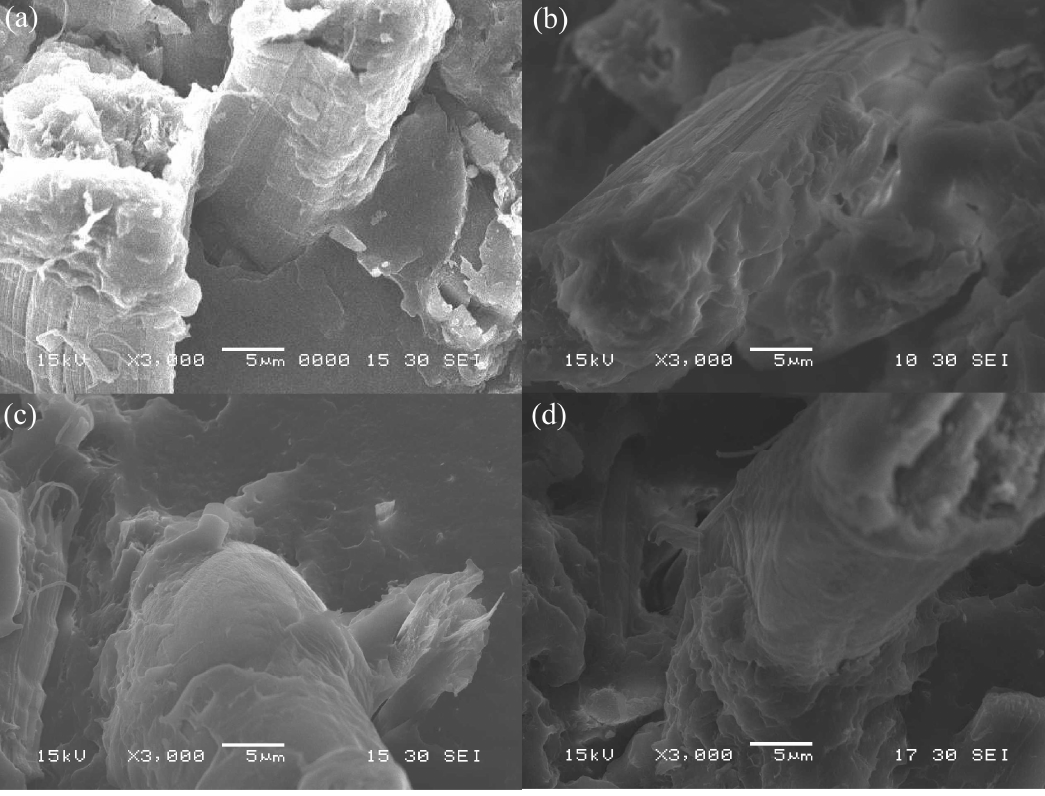
Figure 1. SEM photographs of fracture surface for various surface-treated HF/PA1010 biomass composites: ( a ) HF; ( b ) HF-S1; ( c ) HF-S2 and ( d ) HF-S3 (×3000). composites: ( a ) HF; ( b ) HF-S1; ( c ) HF-S2 and ( d ) HF-S3 ( ×